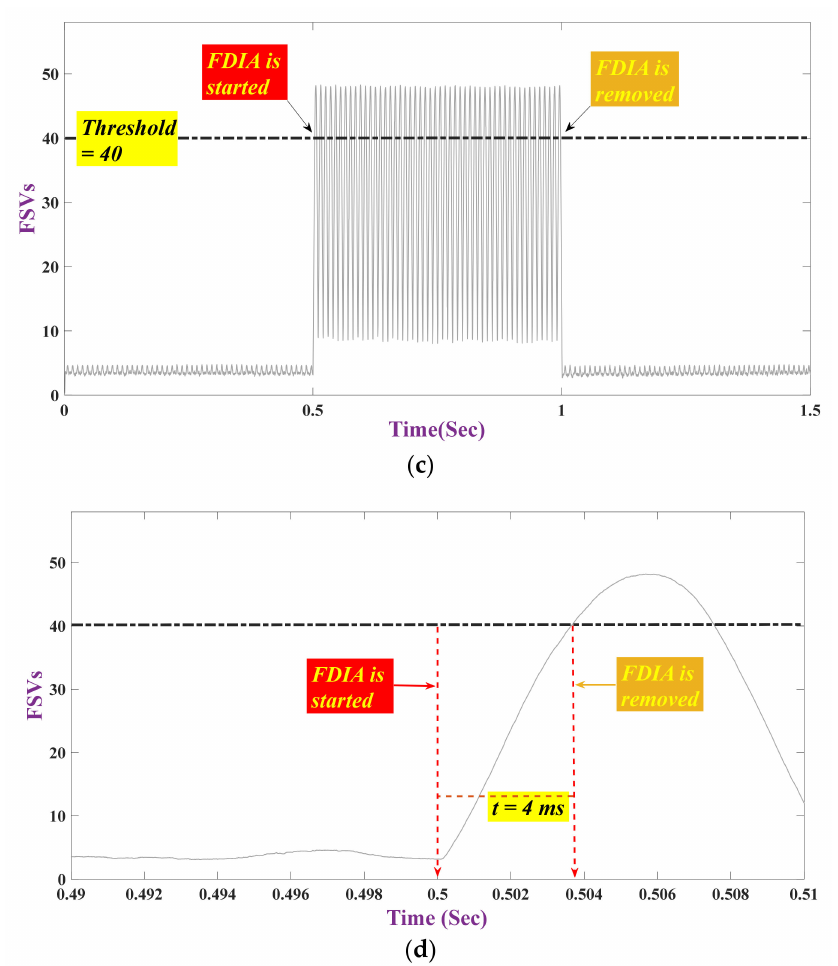
Figure 9. Instability stems from manipulating a voltage signal that is measured by smart sensor (ISMG’s voltage increased): ( a ) ISMG’s voltage; ( b ) Loads current; ( c ) FSVs of signals; ( d ) Time response of FSV’s scheme (FDIA is initiated at t = 0.5 s and is omitted at t = 1